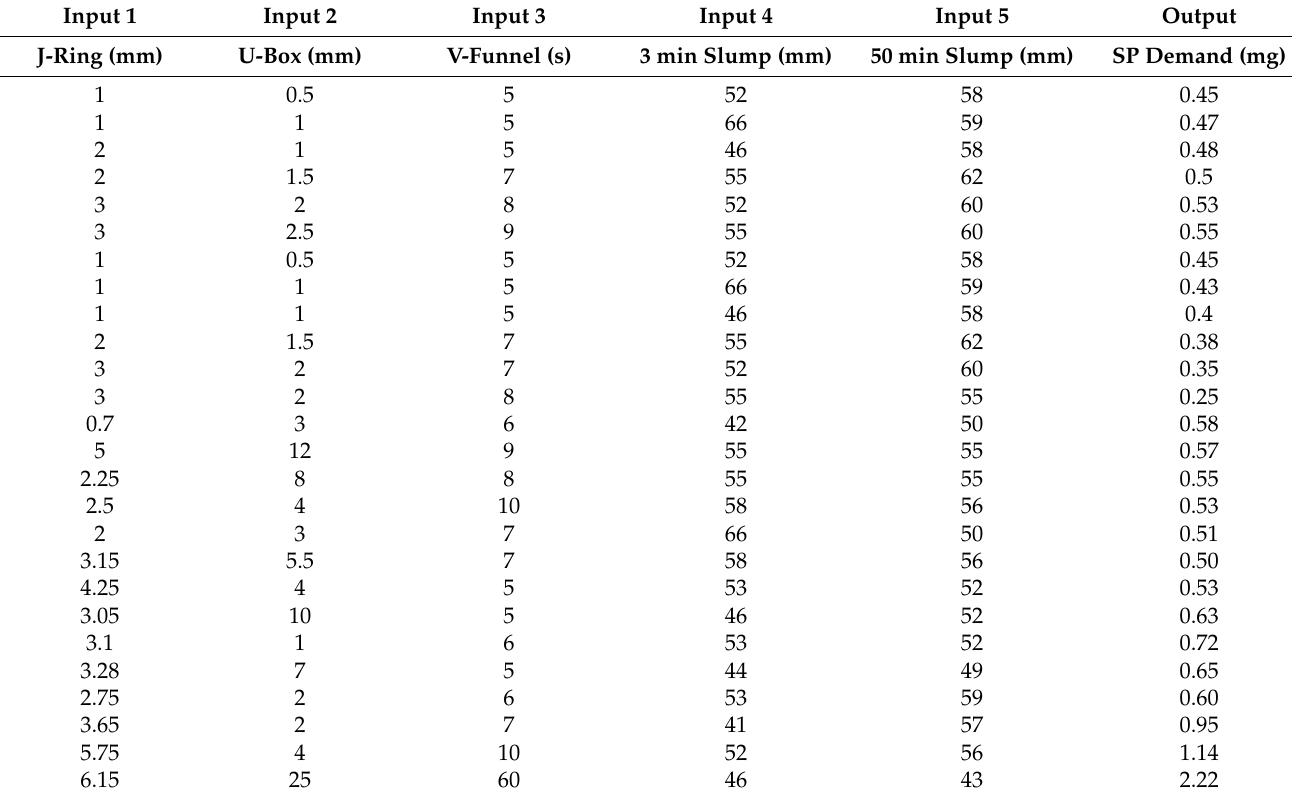
Table 4. Statistical